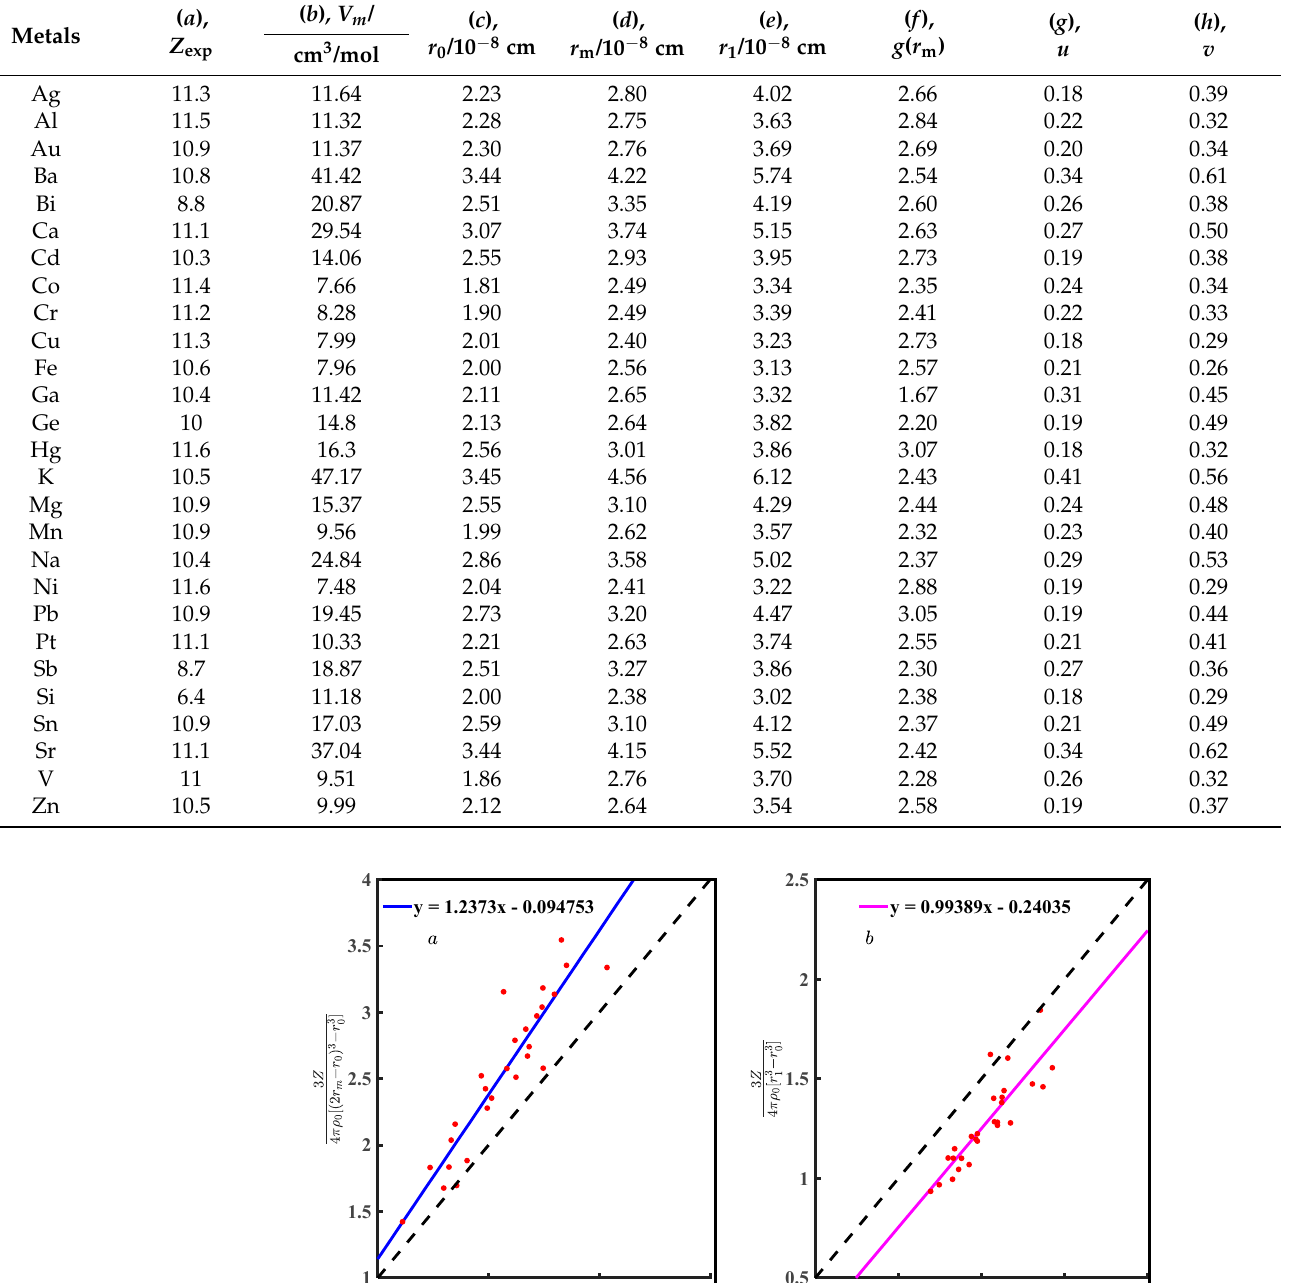
Table 1. The coordination number (CN) (a) [23] (p. 54), molar volume (b) [28] (pp. 71 − 72), g ( r ) parameter (c), (d), (e), and (f), and fitting parameters u and v (g, h) of 27 pure liquid metals.